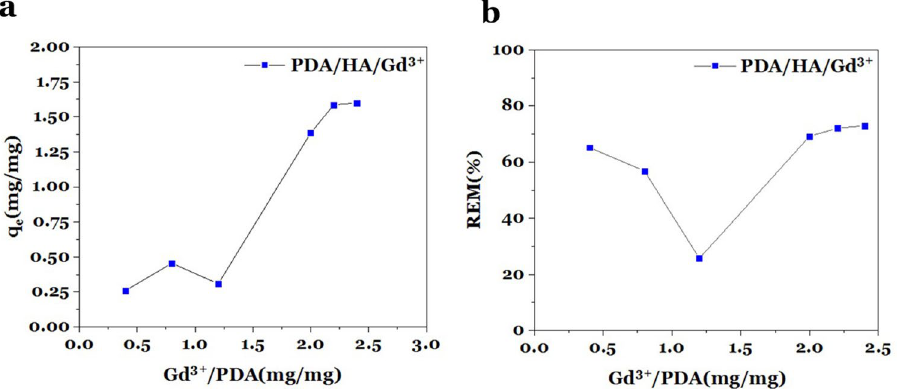
Figure 5. Adsorption study. Ion adsorption (q e ) and adsorption efficiency (REM %) measurements. ( a ) Adsorption graph of Gd 3+ ions on PDA/HA-NPs, and ( b ) Gadolinium ion adsorption efficiency of PDA/